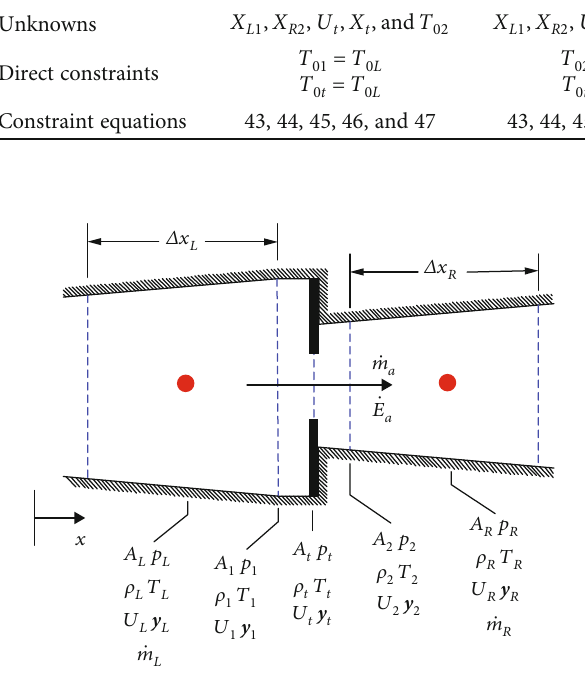
Figure 6: Mass and energy fl ow rate across adjoined pipe boundary.